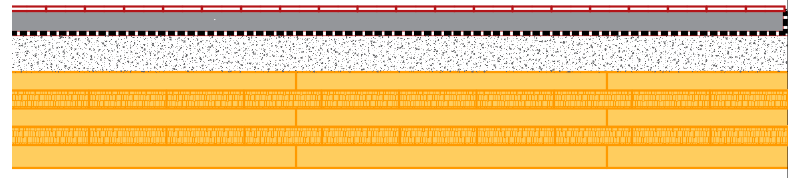
Figure 5. Configuration 3: Bare floor coupled with floating floor.